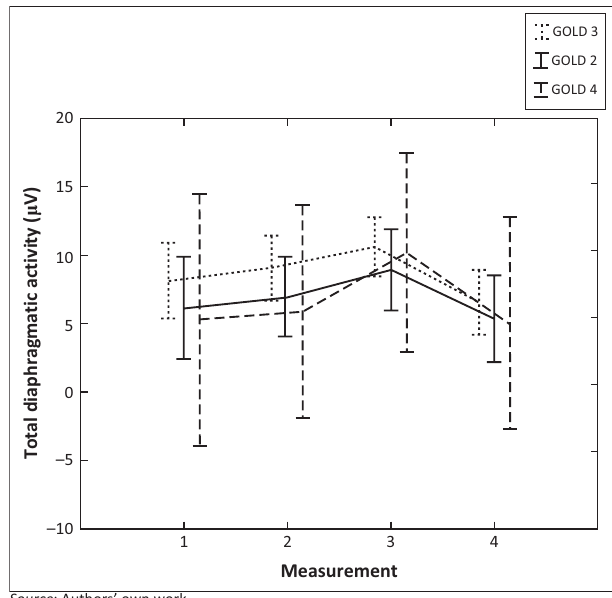
FIGURE 2: Change in diaphragmatic muscle activity according to GOLD classification. Points are mean and vertical bars denote 95 % confidence interval, overall effect p = 0.96.